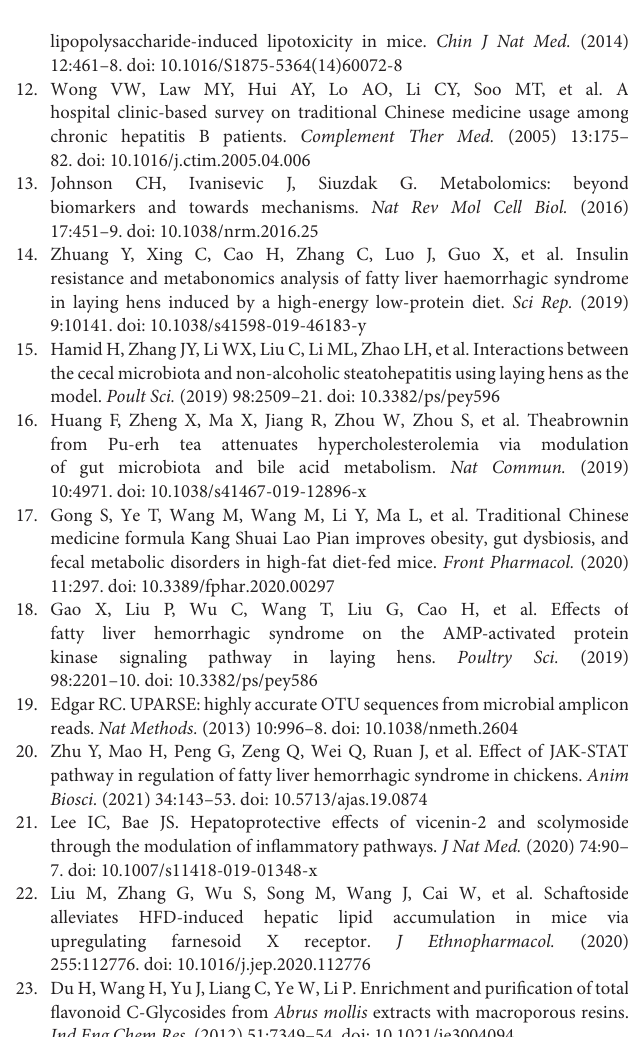
performance liquid chromatography (UPLC)-Q-TOF/MS analysis of liver samples. Supplementary Figure S2 | Permutation test of the corresponding partial least-squares discriminant analysis (PLS-DA) models. Supplementary Figure S3 | Rarefaction curve of the cecal content